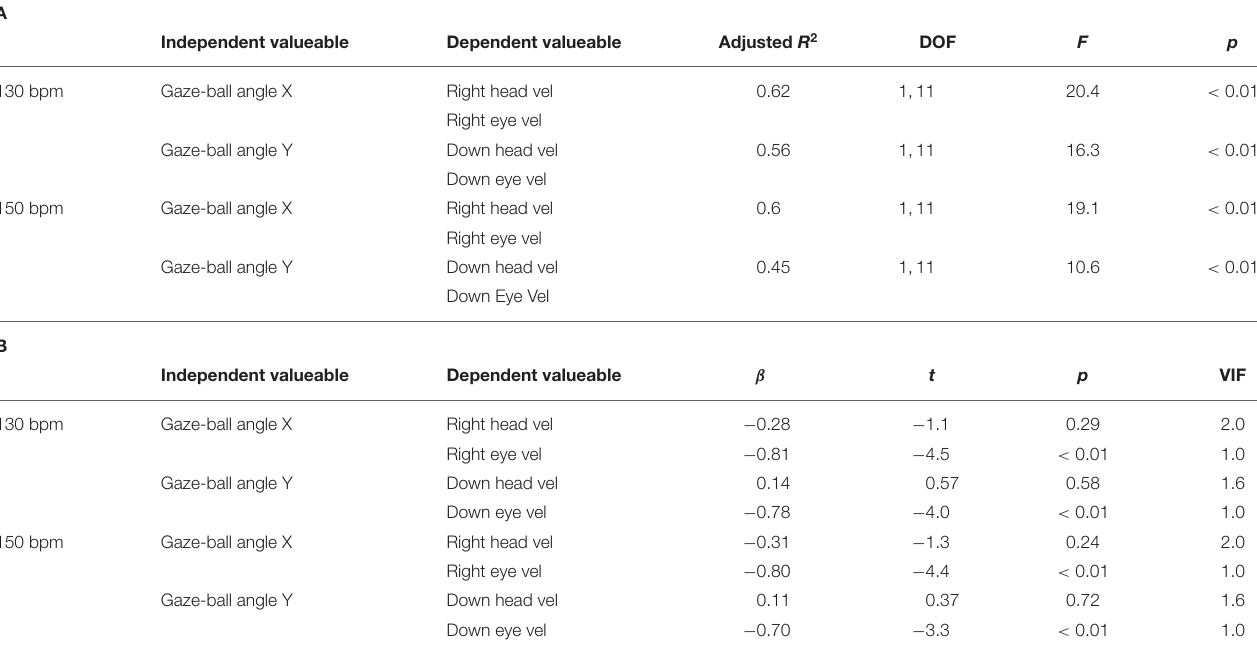
TABLE 5 | Results of multiple regression analysis. (A) Significance of the regression equations, (B) Standardized